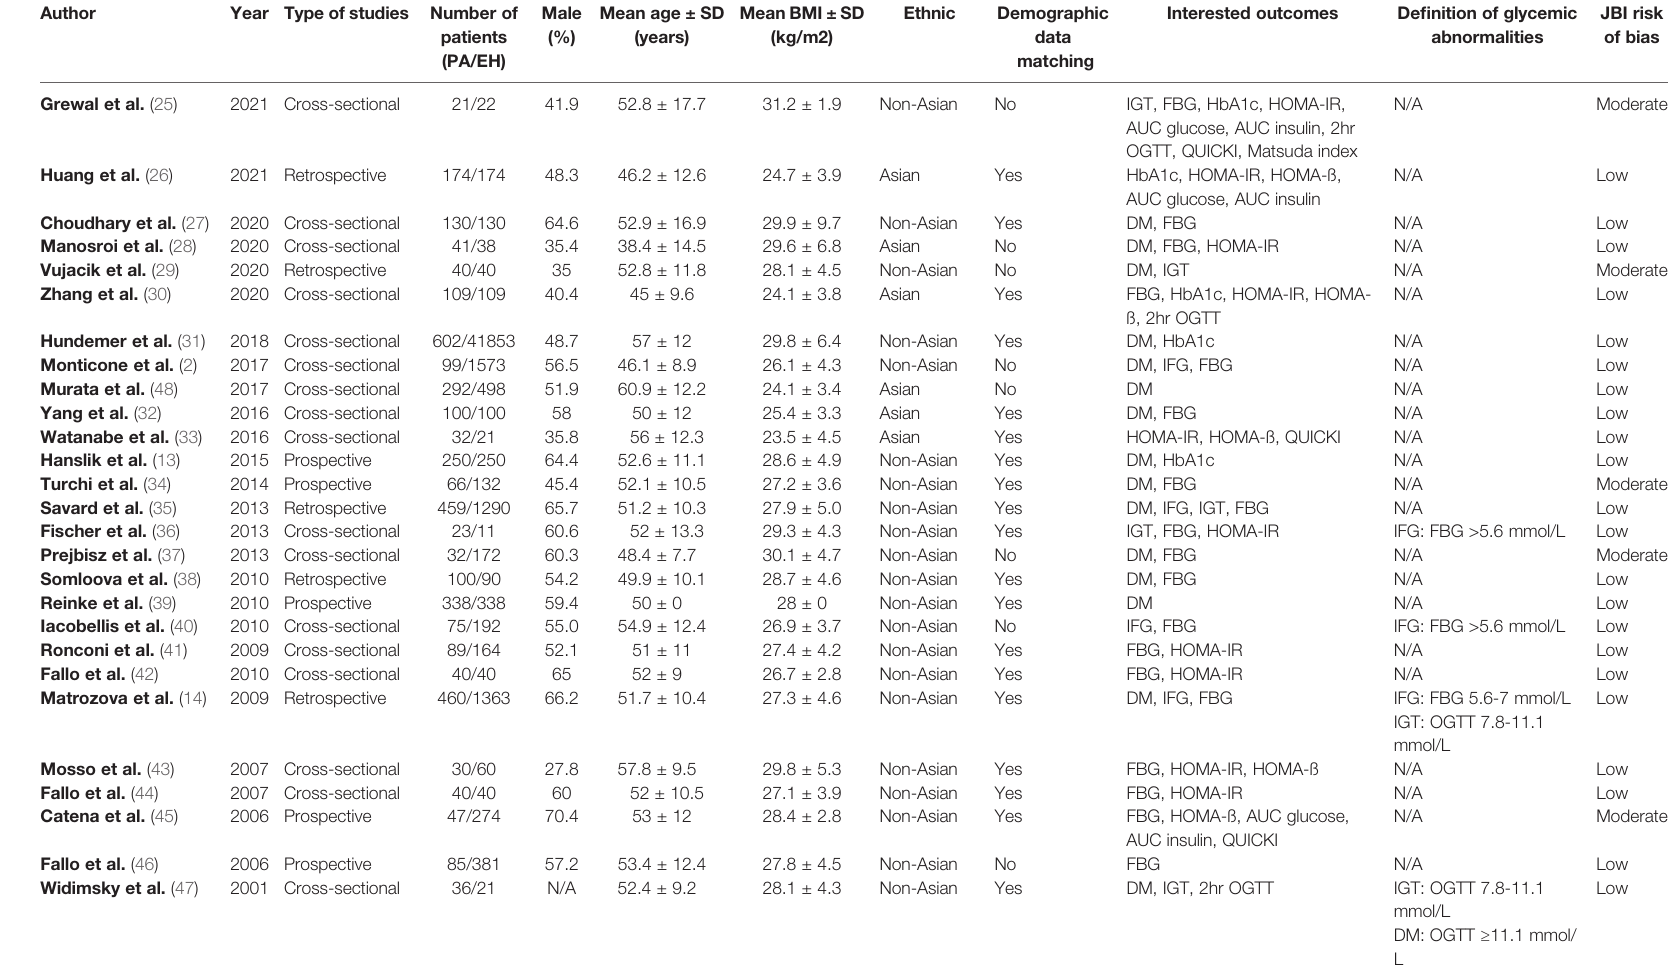
TABLE 1 | Baseline characteristics of the included studies.